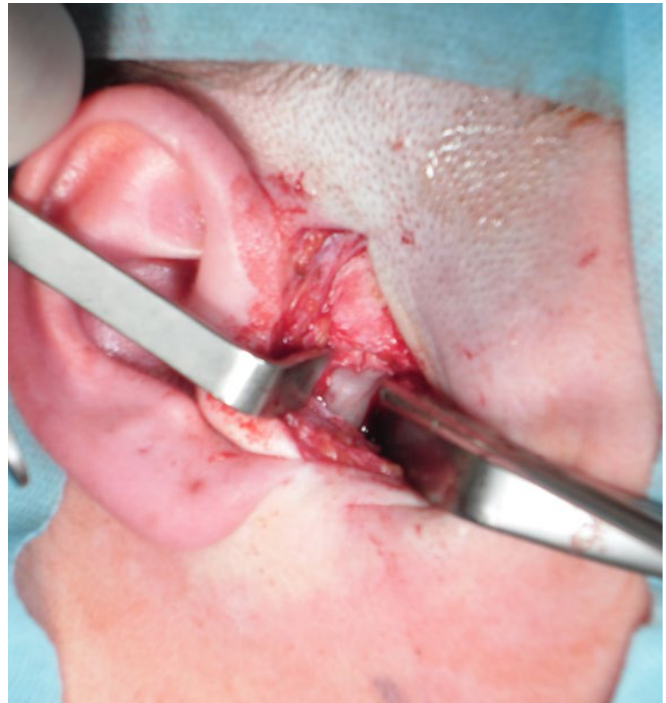
Figure 8. Intraoperative view on low condylectomy with modified pterygoid muscle re-attachment via a classic preauricular approach.